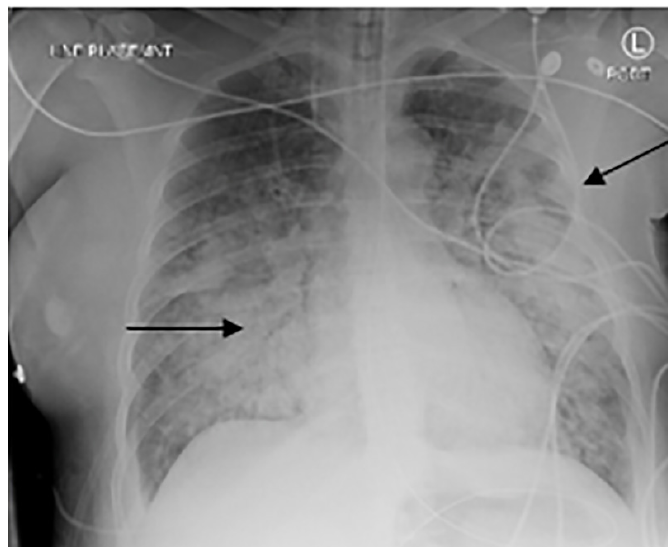
Image 2. Chest radiograph of patient with arrows showing diffuse pulmonary edema